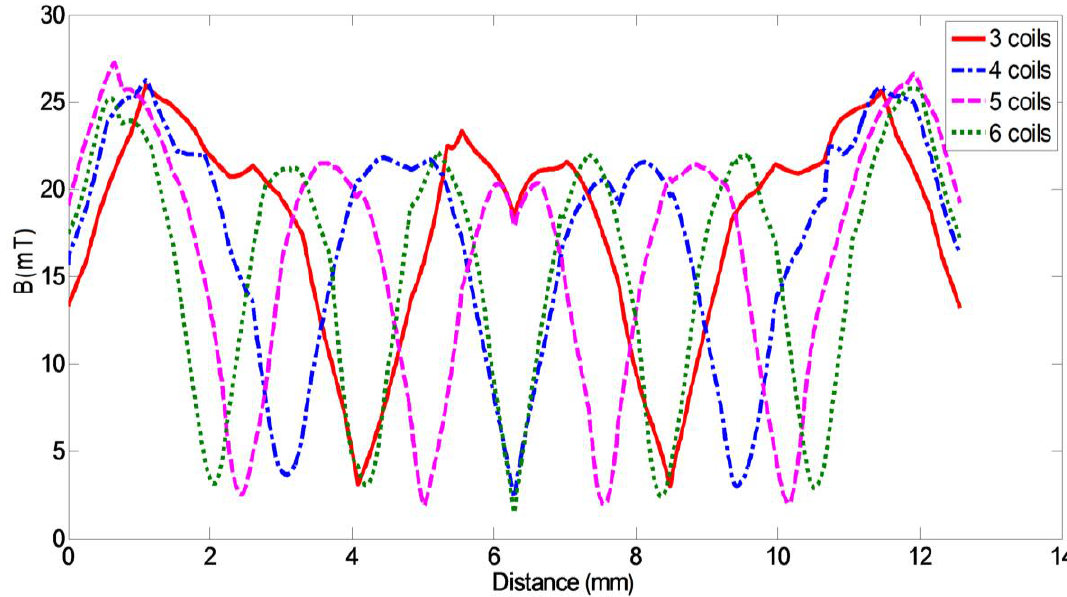
Figure 6. Distribution curves of induction intensities on a steel ball with different probe coils under the same direction excitation current.